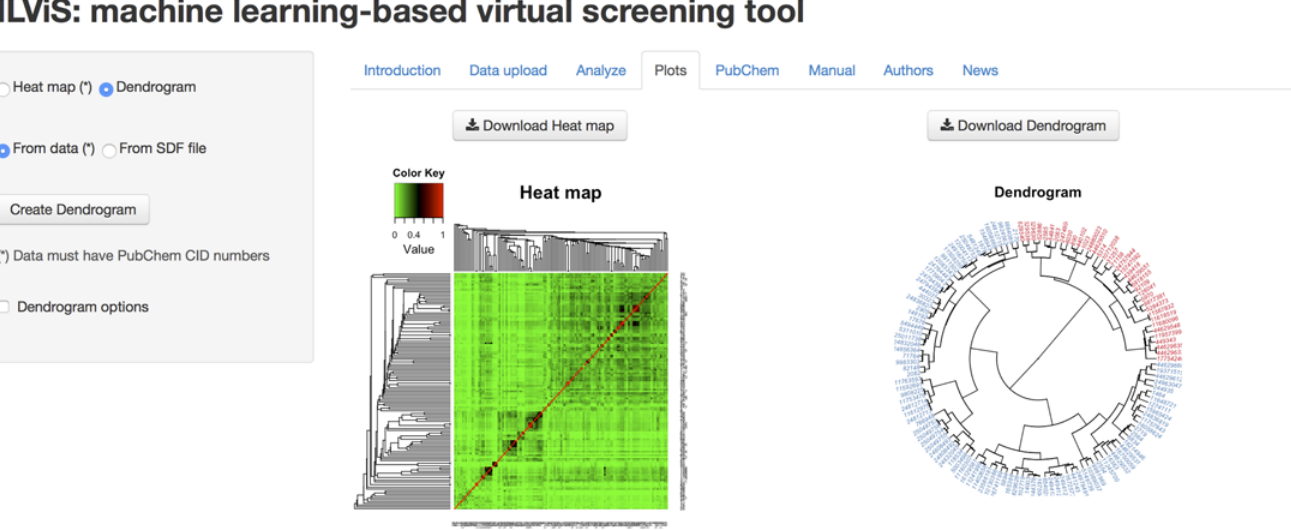
Fig 5. Plot tab of the MLViS web-tool. A dendrogram and a heat map can be created based on the compounds ’ molecular